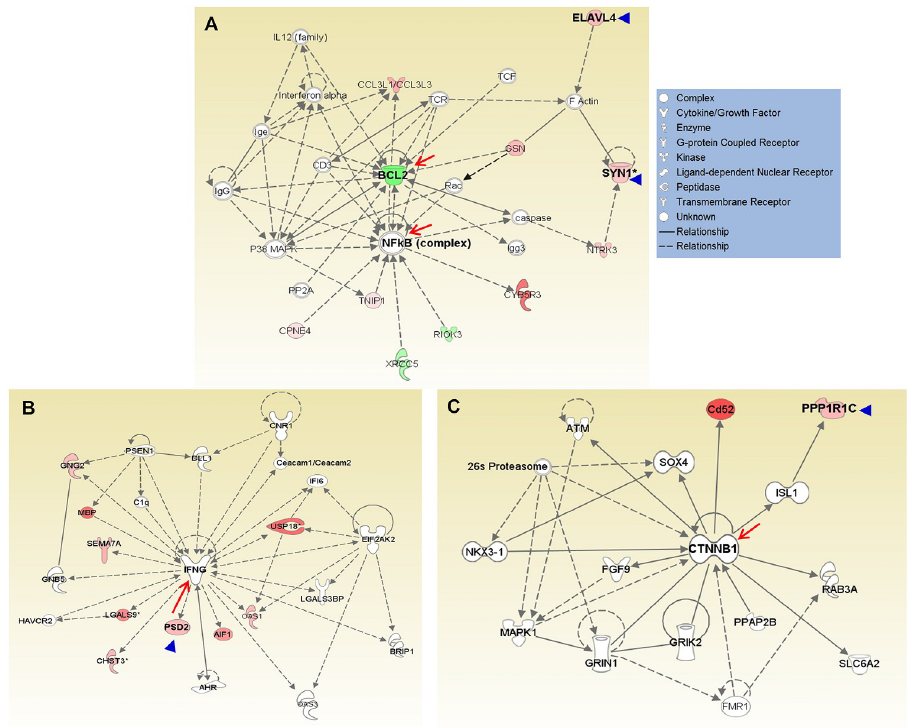
Fig 6. Networks including Elavl4, Ppp1r1c, Psd2, and Syn1 when analyzing differentially expressed genes in the spiral ganglia after kainate treatment. A total of 417 transcripts showed significant changes specific to the spiral ganglion tissues after kainate treatment. (A) Elavl4 and Syn1 were located in Network 1 (score = 29) with NFkB and BCL2 as the central hubs. (B) Psd2 was located in a network (score = 19) with interferon γ as the hub. (C) Ppp1r1c was located in a network (score = 11) with CTNNB1 as the hub. Arrow heads indicate the 4 genes with consistently significant changes at both 5 h and 24 h after kainate treatment; arrows indicate molecular hubs of the networks.